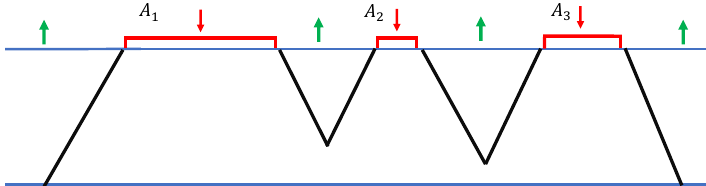
Figure 27 . Example of a configuration contributing to the partition function for (A.9). The set γ corresponding to this configuration is { l 1 , r 3 , { l 2 , r 1 } , { l 3 , r 2 }} . Hilbert space, we get a factor of 1 from each site on the lower boundary, irrespective of q whether the lowermost bulk layer has an ↑ or ↓ spin at that site. 13 Thus irrespective of where the domain walls end, we get a factor of 1 from the lower boundary, cancelling with q L the prefactor q L in (A.9). Effectively the bottom boundary does not play any